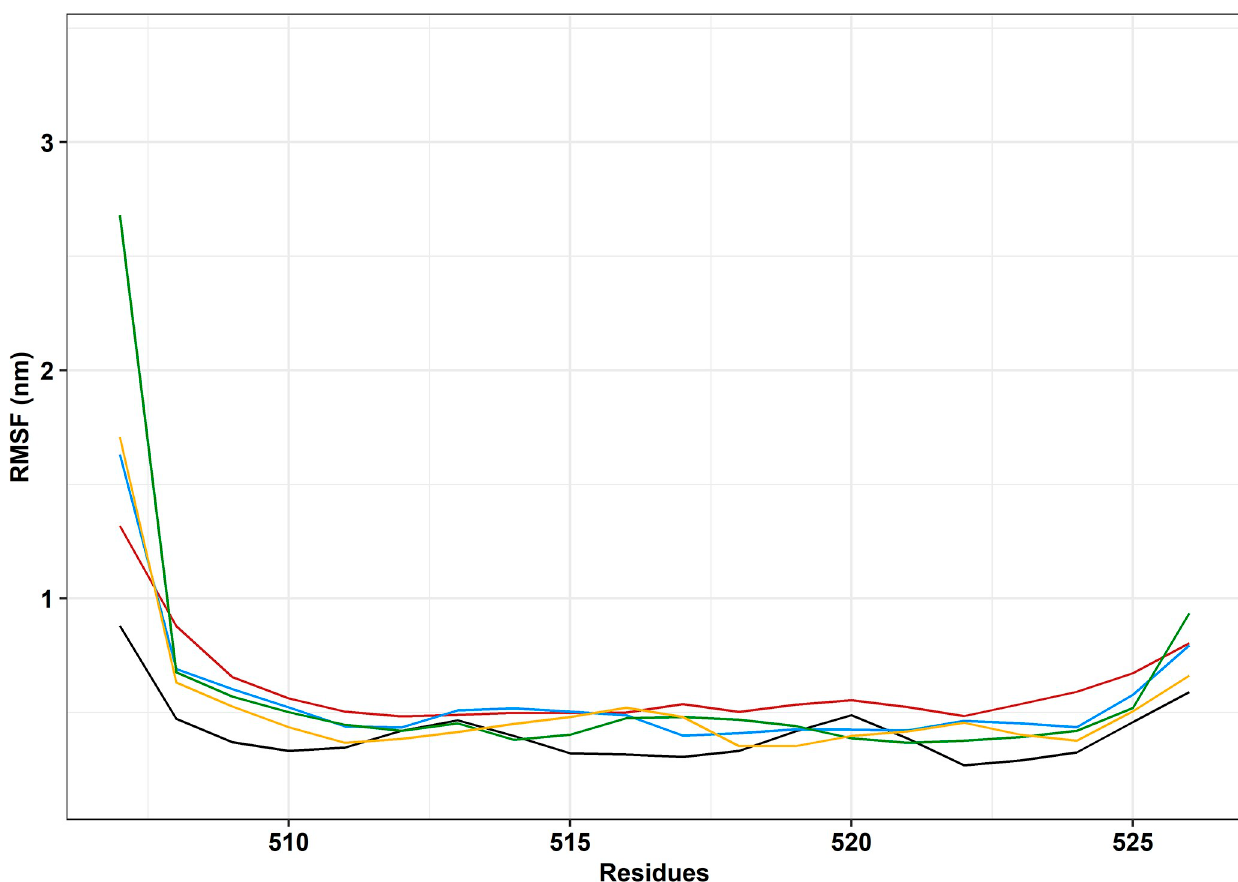
Fig 5. Root mean square fluctuation (RMSF) of the backbone atoms of the protein as a function of each amino acid residue. The wild-type FUS protein is represented in black, variant R521C is represented in blue, variant 521H is represented in green, variant P525L is represented in red, and variant P525L-PDB [ID: 7CYL] is represented in